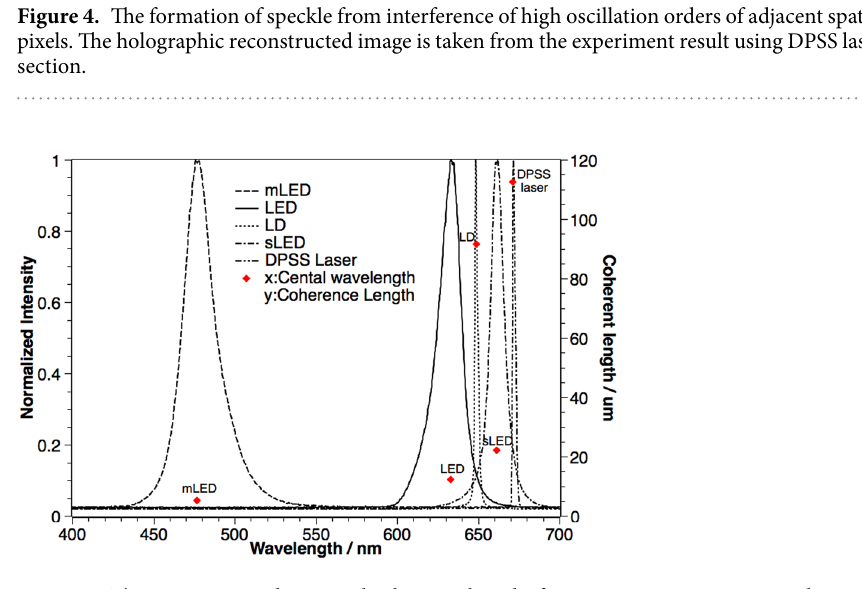
Figure 5. The spectrums and temporal coherence lengths for mLED, LED, LD, sLED and DPSS